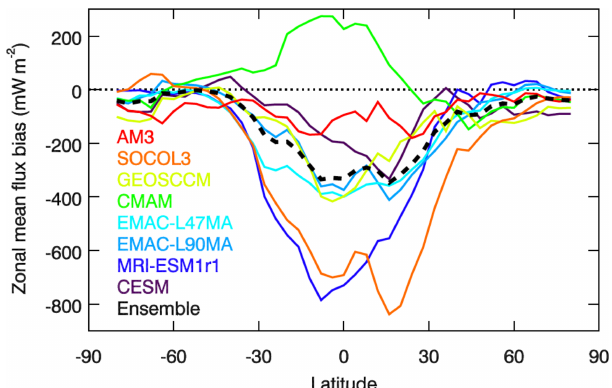
Figure 3. The latitudinal distribution of the zonal flux bias (model – reanalysis) with latitude